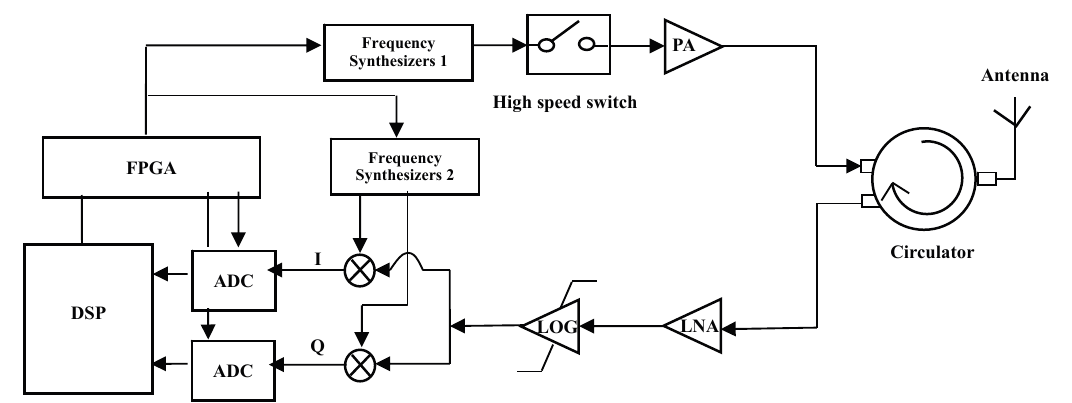
Figure 5. Block diagram of the interrogation